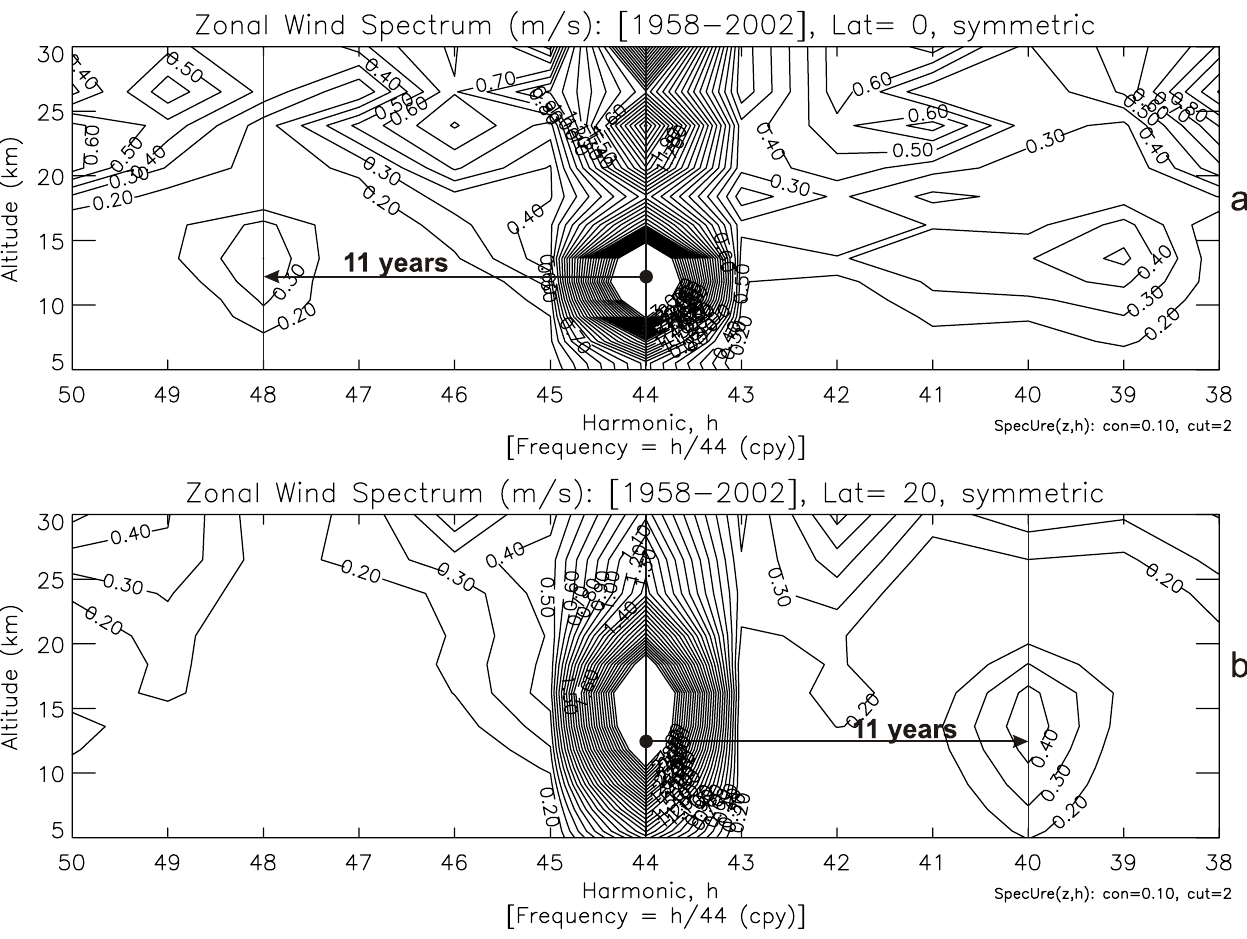
Fig. 1. Spectra covering 44 years from 1958–2002 for the hemispherically symmetric NCEP/NCAR Re-1 zonal winds at the equator (a) and 20 ◦ latitude (b) . Amplitudes are plotted versus Fourier harmonics, h, and altitude. The corresponding frequencies are then h/44 (cycles per year, cpy), and the periods are 44/h (years). With contour intervals of 0.1m/s, the 12-month annual oscillation (AO) at h=44 is saturated. Weak signatures of the 11-year modulation (h=4) are evident at h=48 (44+4) in (a), and at h=40 (44 − 4) in (b). The spectra for the subsequent 44-year windows, starting in 1959 and shifted by one year, show similar